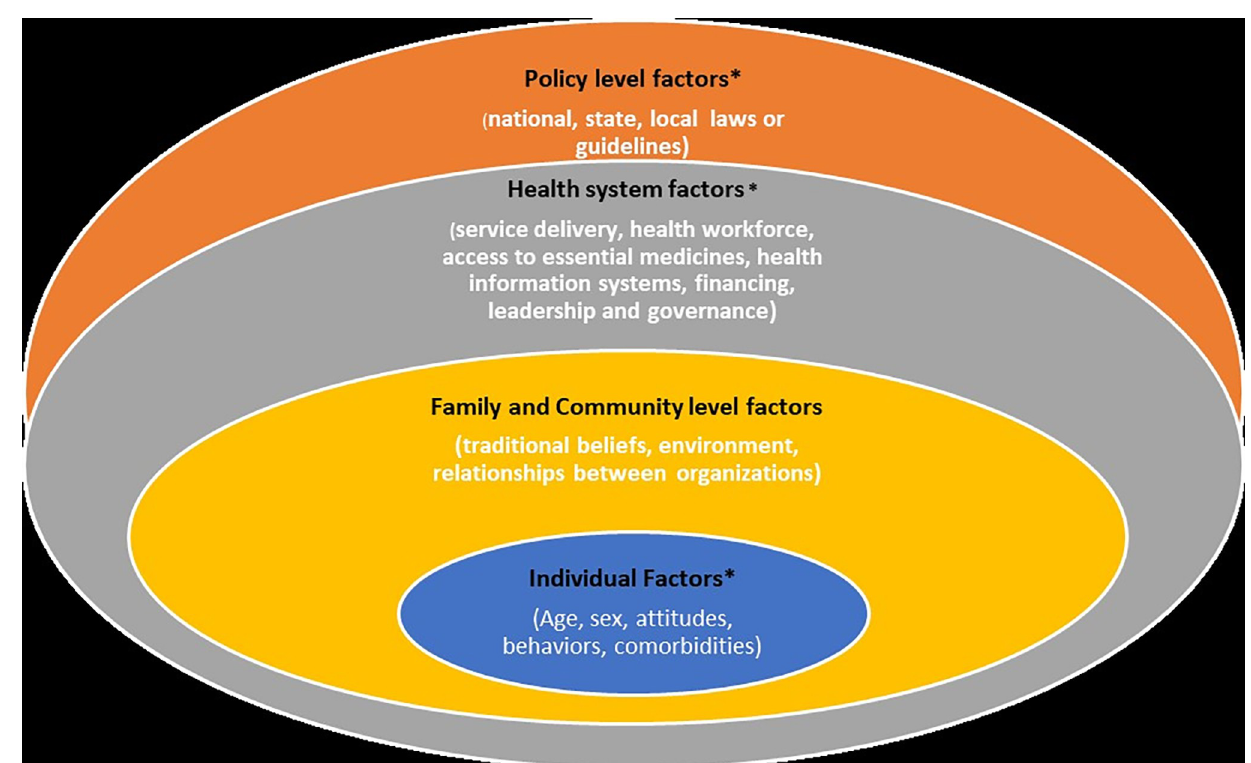
Fig 1. Factors affecting uncontrolled hypertension at the different